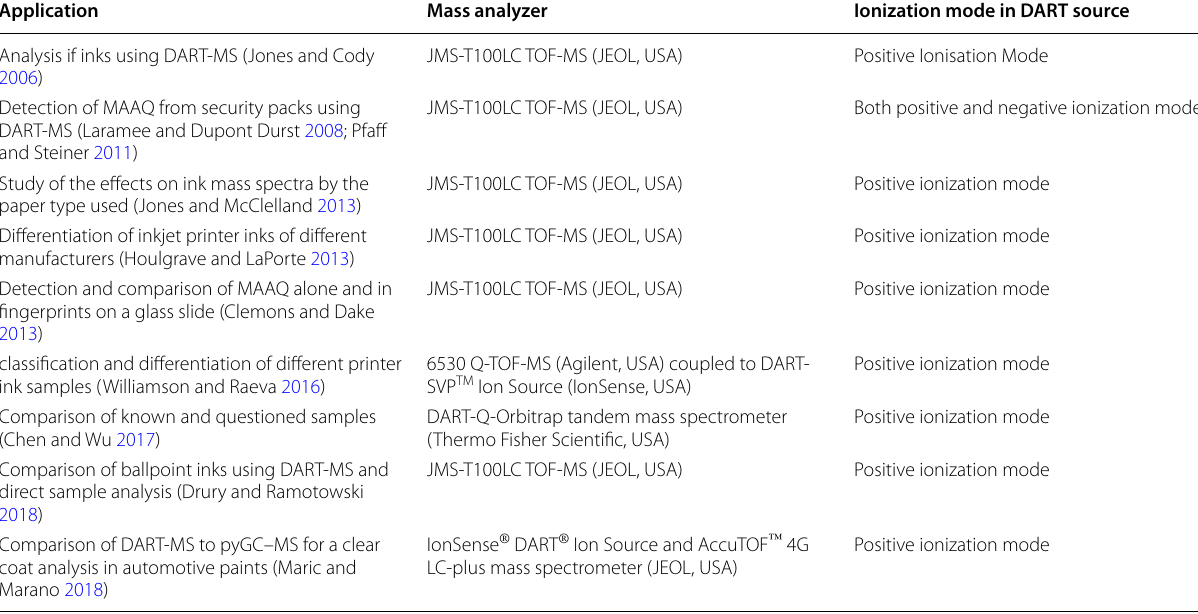
Table 10 Applications of various inks, dyes, and paints along with the type of mass analyzer used for their